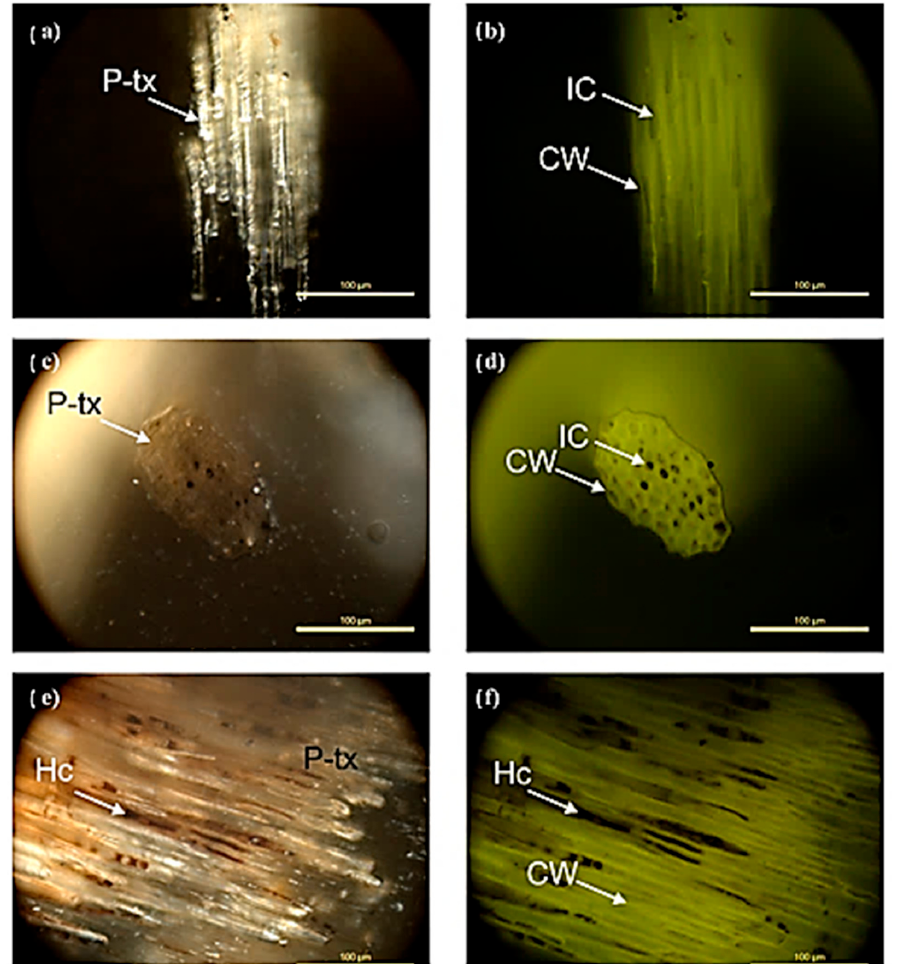
Figure 5. Photomicrographs of Posidonia Oceanic balls taken under white incident light ( a , c , e ) and blue-light excitation ( b , d , f ) in oil immersion and total magni fi cation of ×500: ( a , b ) view in parallel to the PO fi bers showing visible cell structure and strong internal re fl ections and fl uorescence of cellulose and semi-cellulose remnants; ( c , d ) view in perpendicular to the PO fi bers; and ( e , f ) view in parallel to the PO fi bers showing visible in fi lling of the intracellular space with humi fi ed non- fl uorescing colloids, which have probably originated from the protoplasm (CW: cell-wall, Hc: humic colloids, IC: intracellular space, P-tx: pre-textinite).